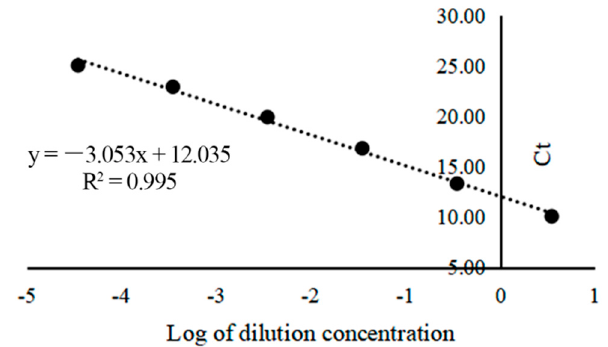
Figure 6. Standard curves showing the relationship between the log of the dilution concentration and the Ct value.